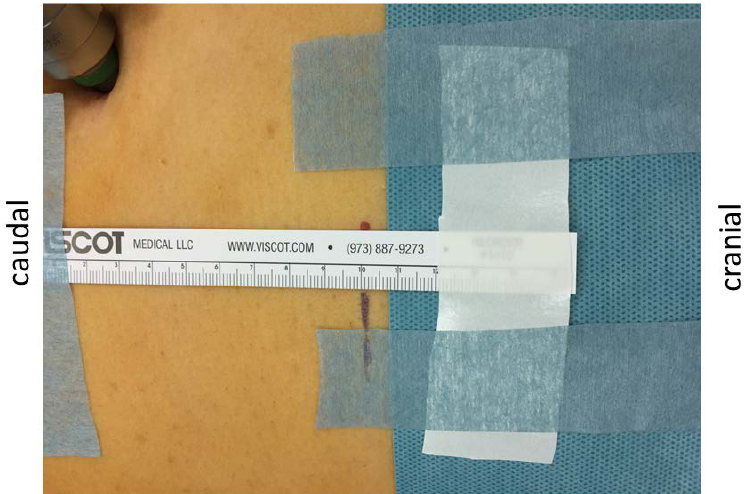
Figure 2. Measurement of the abdominal wall length. The flexible tape is fixed at the caudal end, while it is free to move at the cranial side. A distance of 100 mm from a fixed caudal point (not visible in the figure) is marked cranially (black line).